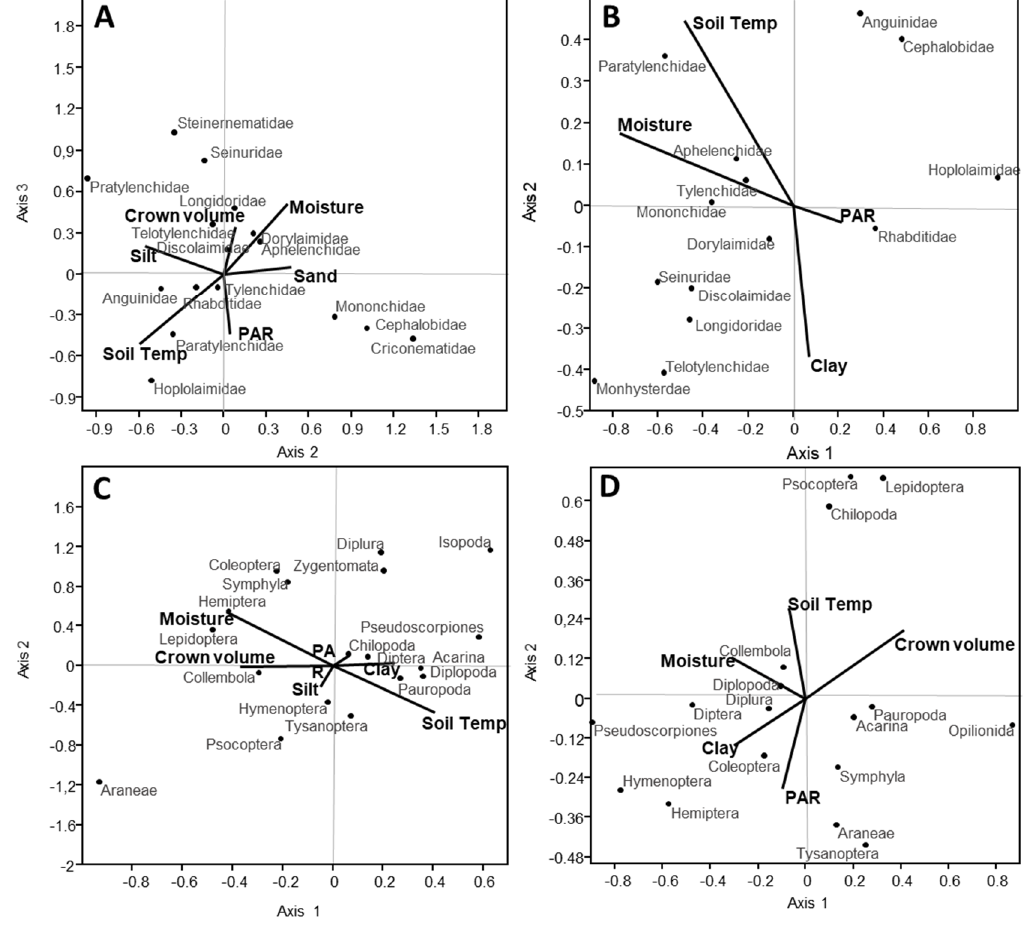
Figure 4. Scatter plots of Canonical Correspondence Analysis (CCA) ordination showing relationships between soil and forest properties and taxa abundance. Nematodes: Pratomagno ( A ), percentage explained was 28.6% for axis 2 ( p < 0.007) and 19.4% for axis 3 ( p < 0.001), Amiata ( B ), percentage explained was 70.0% for axis 1 ( p > 0.05) and was not significant for axis 2. Microarthropods: Pratomagno ( C ), percentage explained was 54.5% for axis 1 ( p < 0.03) and 25.2% for axis 2 ( p < 0.001), Amiata ( D ), percentage explained was 70.6% for axis 1 ( p < 0.04) and was not significant for axis 2.